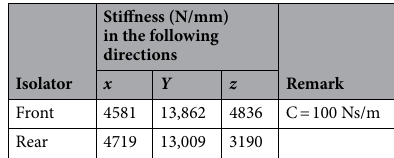
Table 1. Bush properties of the simplified